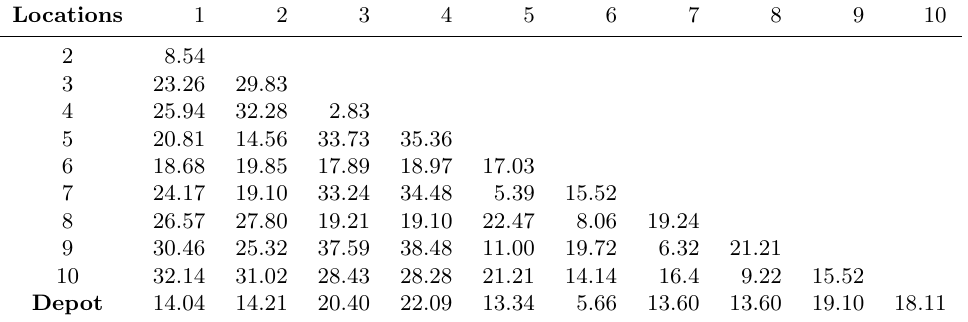
Table 2: Distance matrix for illustrative example.